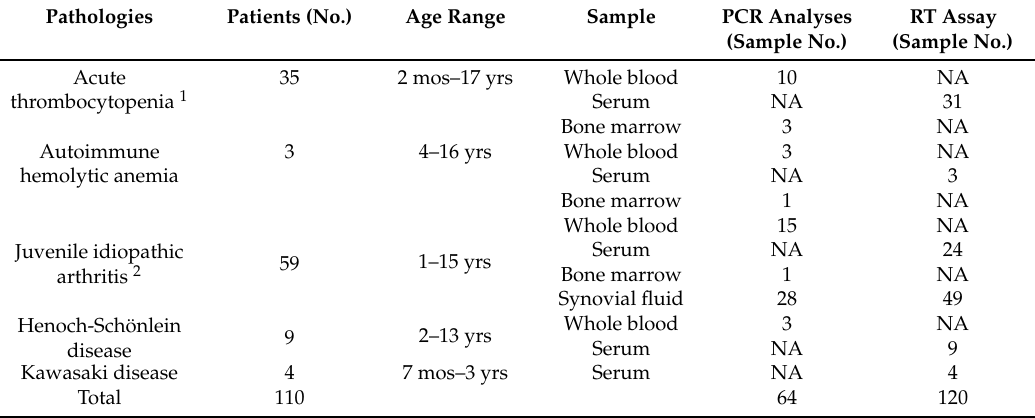
Table 2. Patient characteristics and processing of pediatric samples. PCR analyses were performed with the primer sets shown in Table 1, designed specifically to amplify env sequences from BLV, FeLV, PERV, GaLV, MMTV, MMPV, and PTLV. MLV, FeLV, PERV or spumavirus presence was assayed by RT